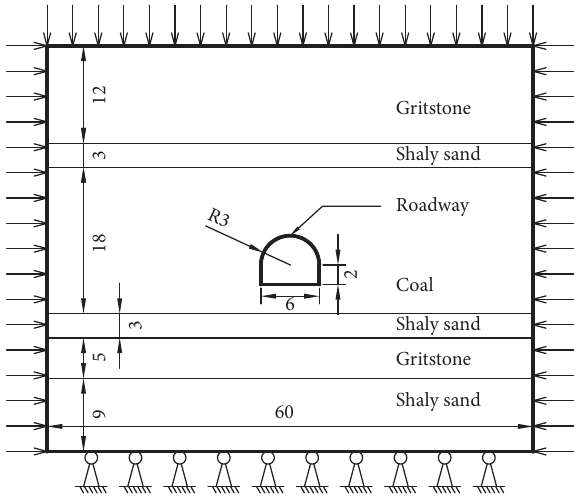
Figure 5: Model size and boundary conditions.